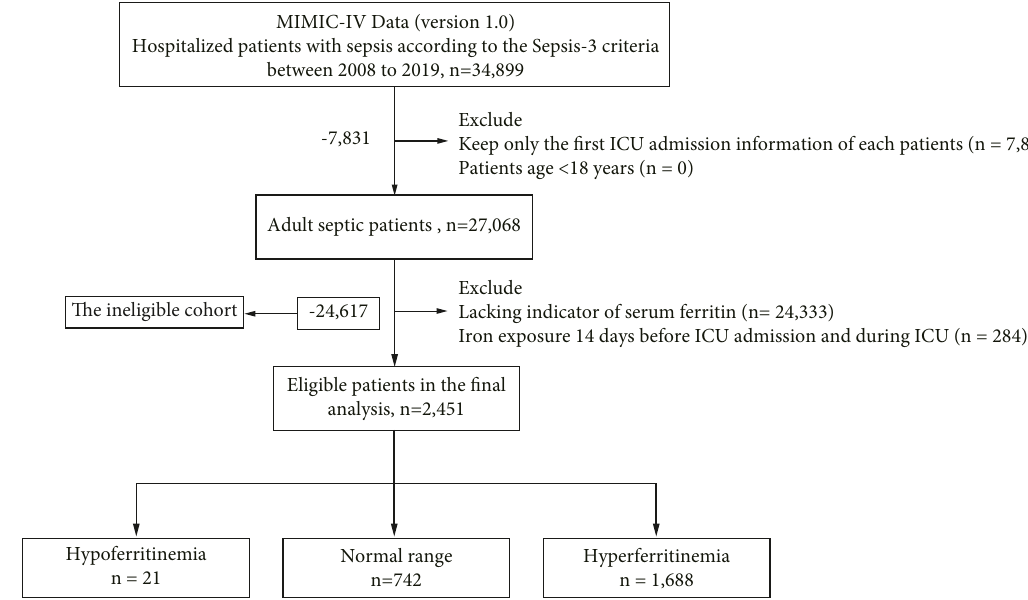
Figure 1: Te fow